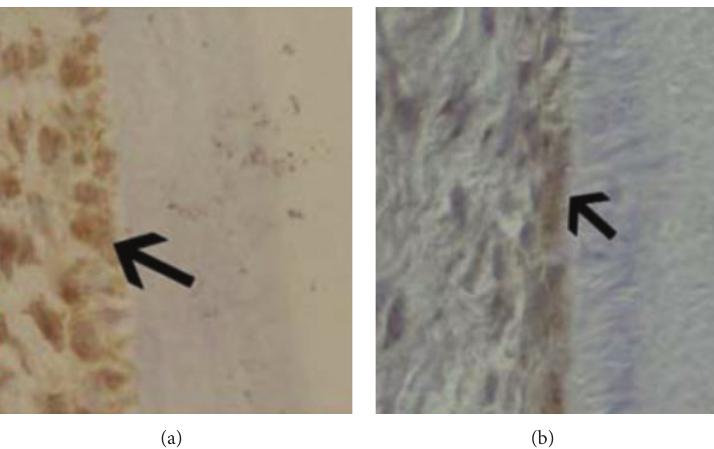
Figure 7: Immunohistochemical images of the root-close part of the periodontal membrane on a primary tooth from a child aged 6 (left) and a permanent tooth from a child aged 10 (right). The brown colour shows positive reaction for Caspase-3 which marks apoptosis activity [100]. The inner periodontal cell layer toward the root is thus under constant cell necrosis (restructuring) during the eruption process.